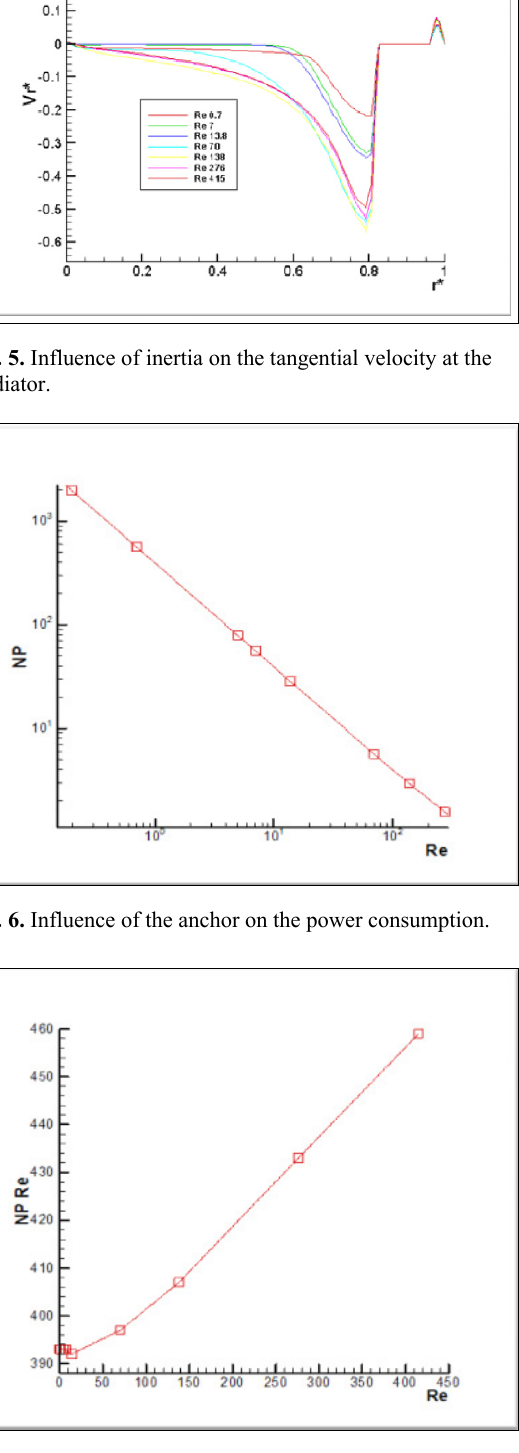
Fig. 7. Influence of the anchor on the Product (Np *